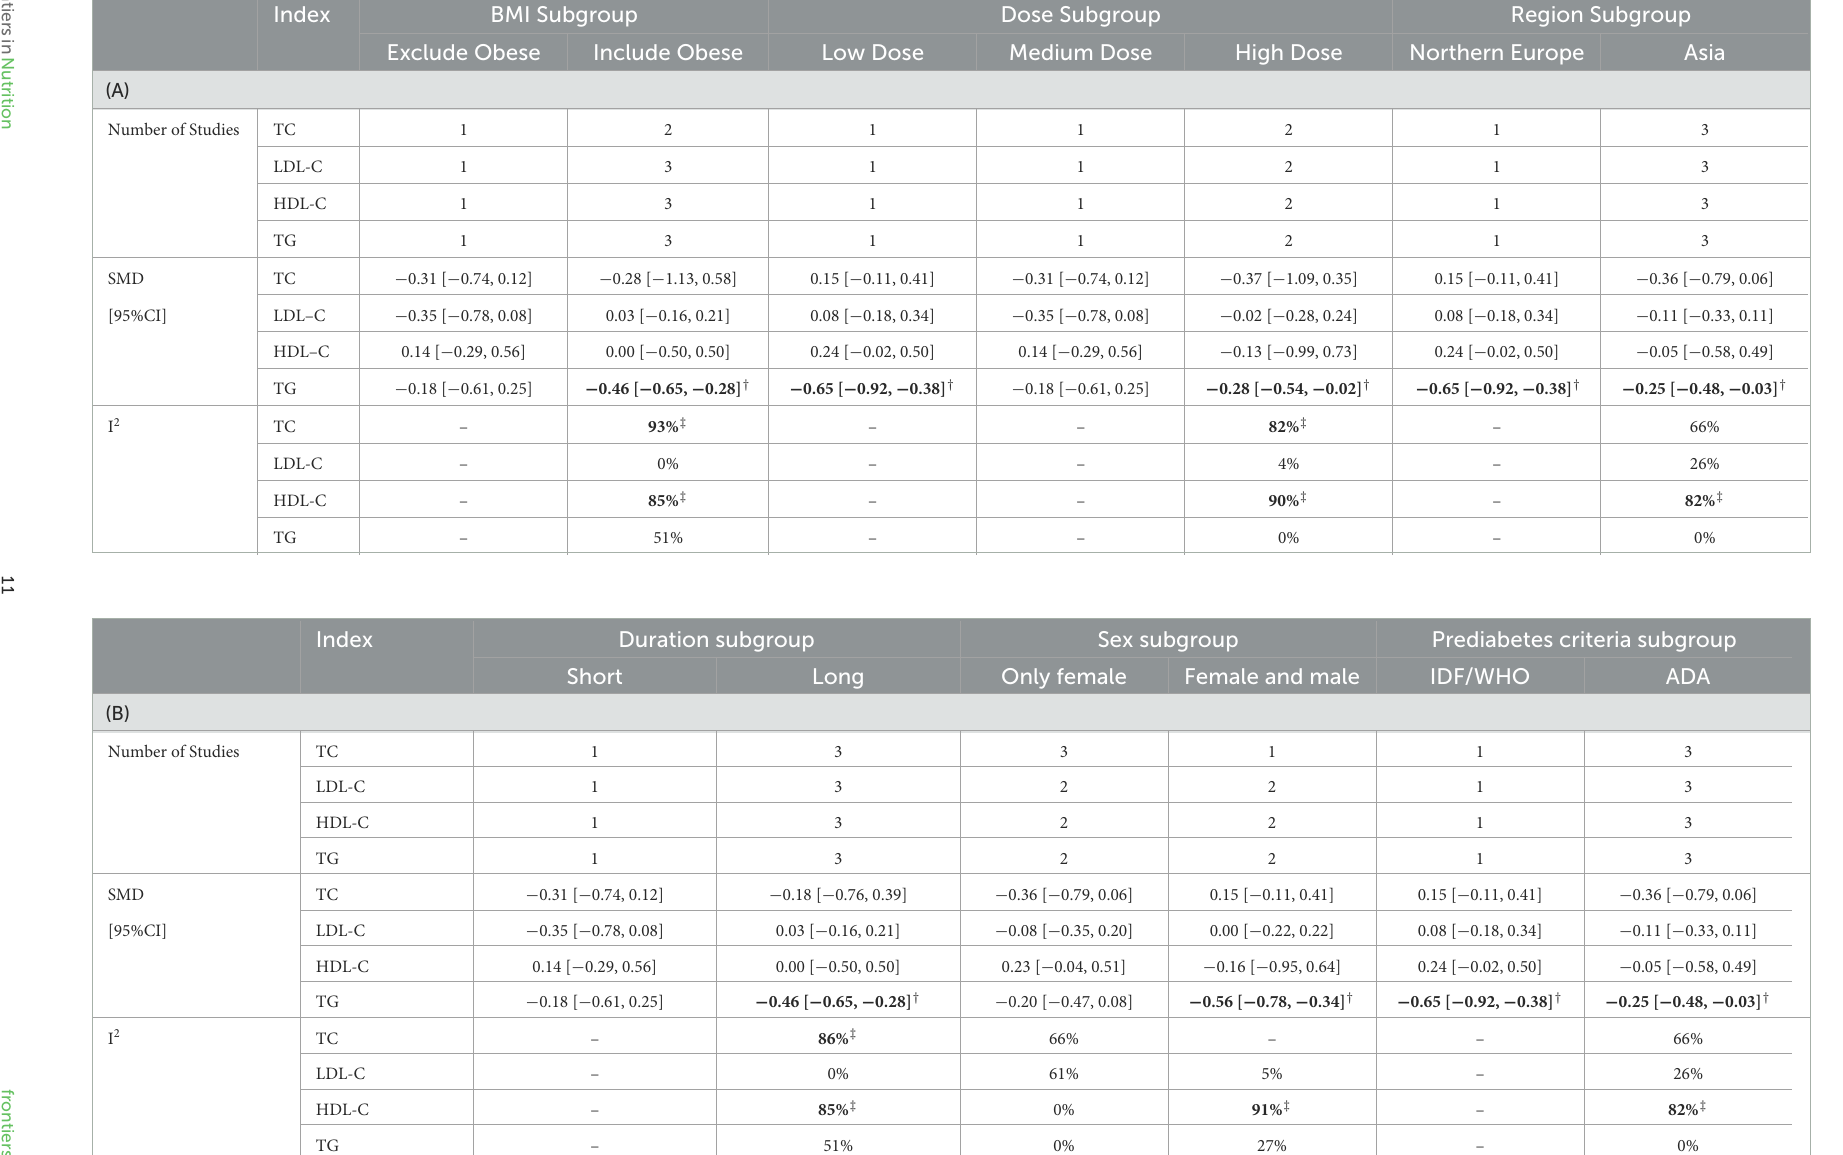
TABLE 3 Results of subgroup